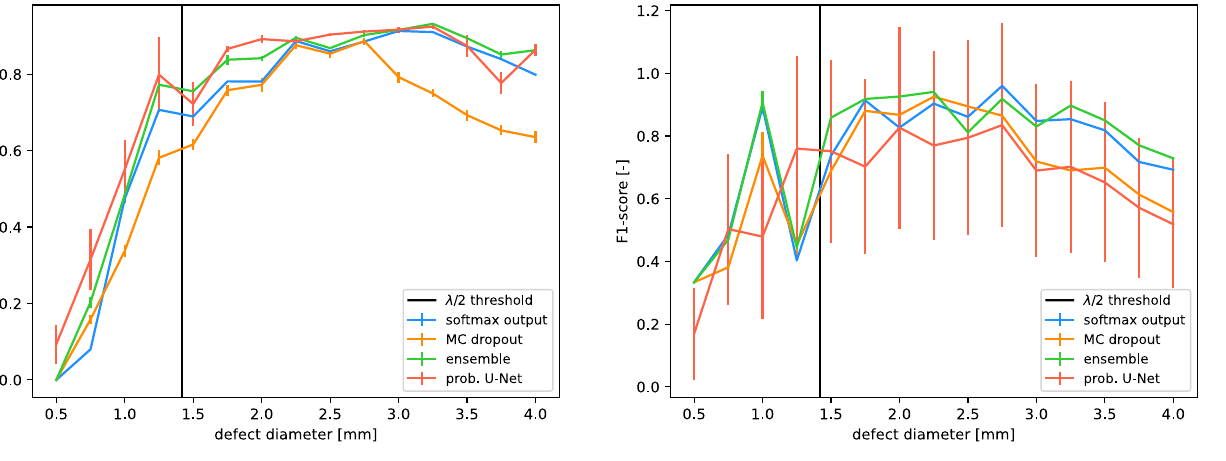
Fig. 13 Dependency of the F1-score from the defect size for round defects